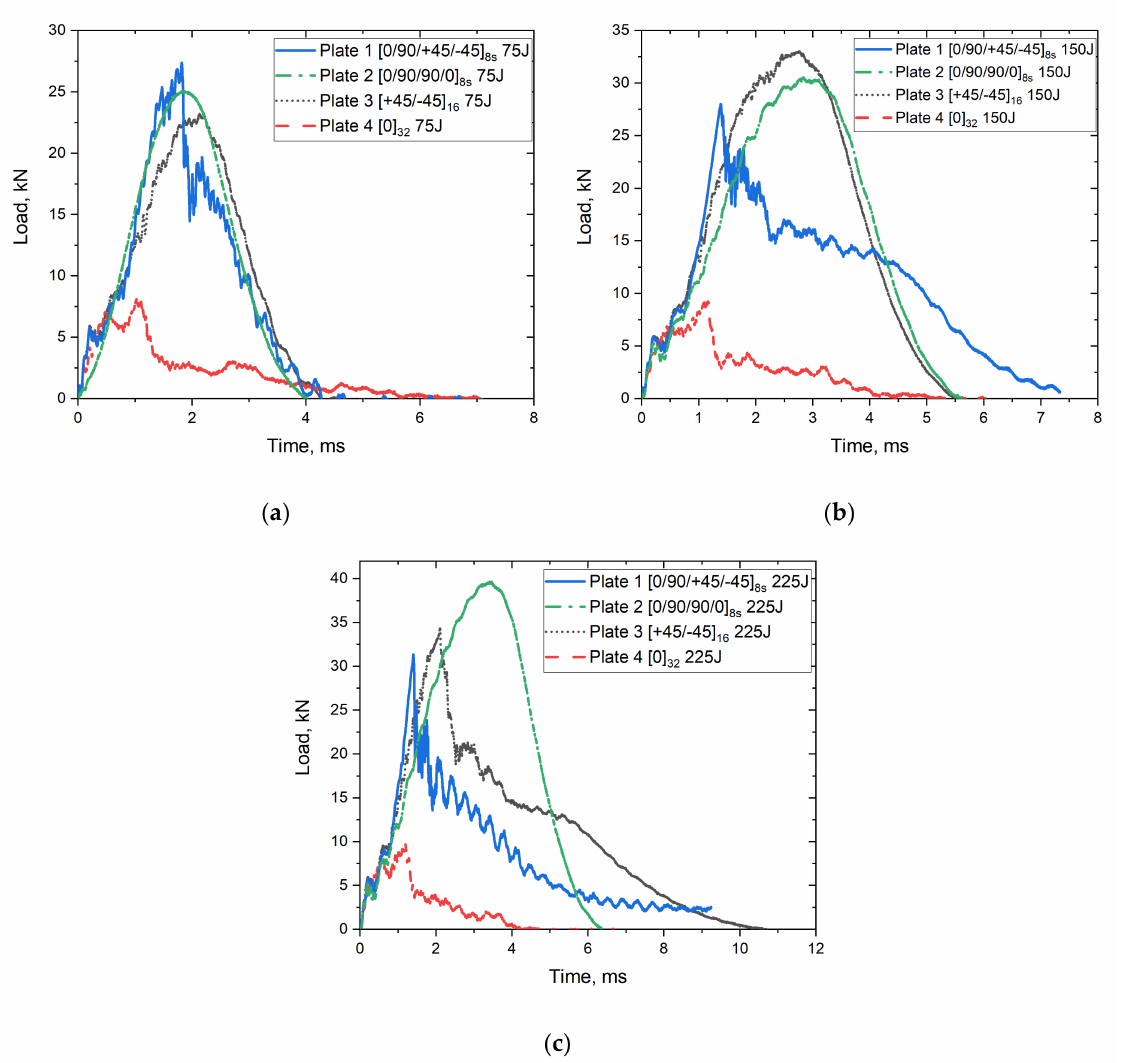
Figure 5. Load vs. time curves for S2/FM94 glass fibre plates with different fibre orientation systems under ( a ) 75 J, ( b ) 150 J, and ( c ) 225 J impact